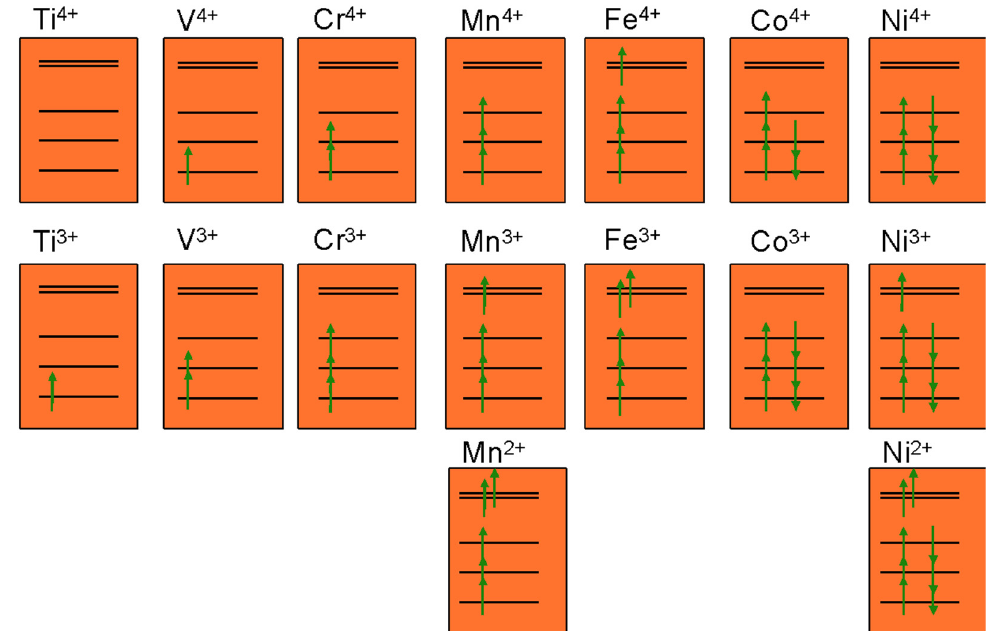
Figure 4. Expected transition metal band filling in the three t 2g and two e g * states for 3 d transition metals in octahedral environments.